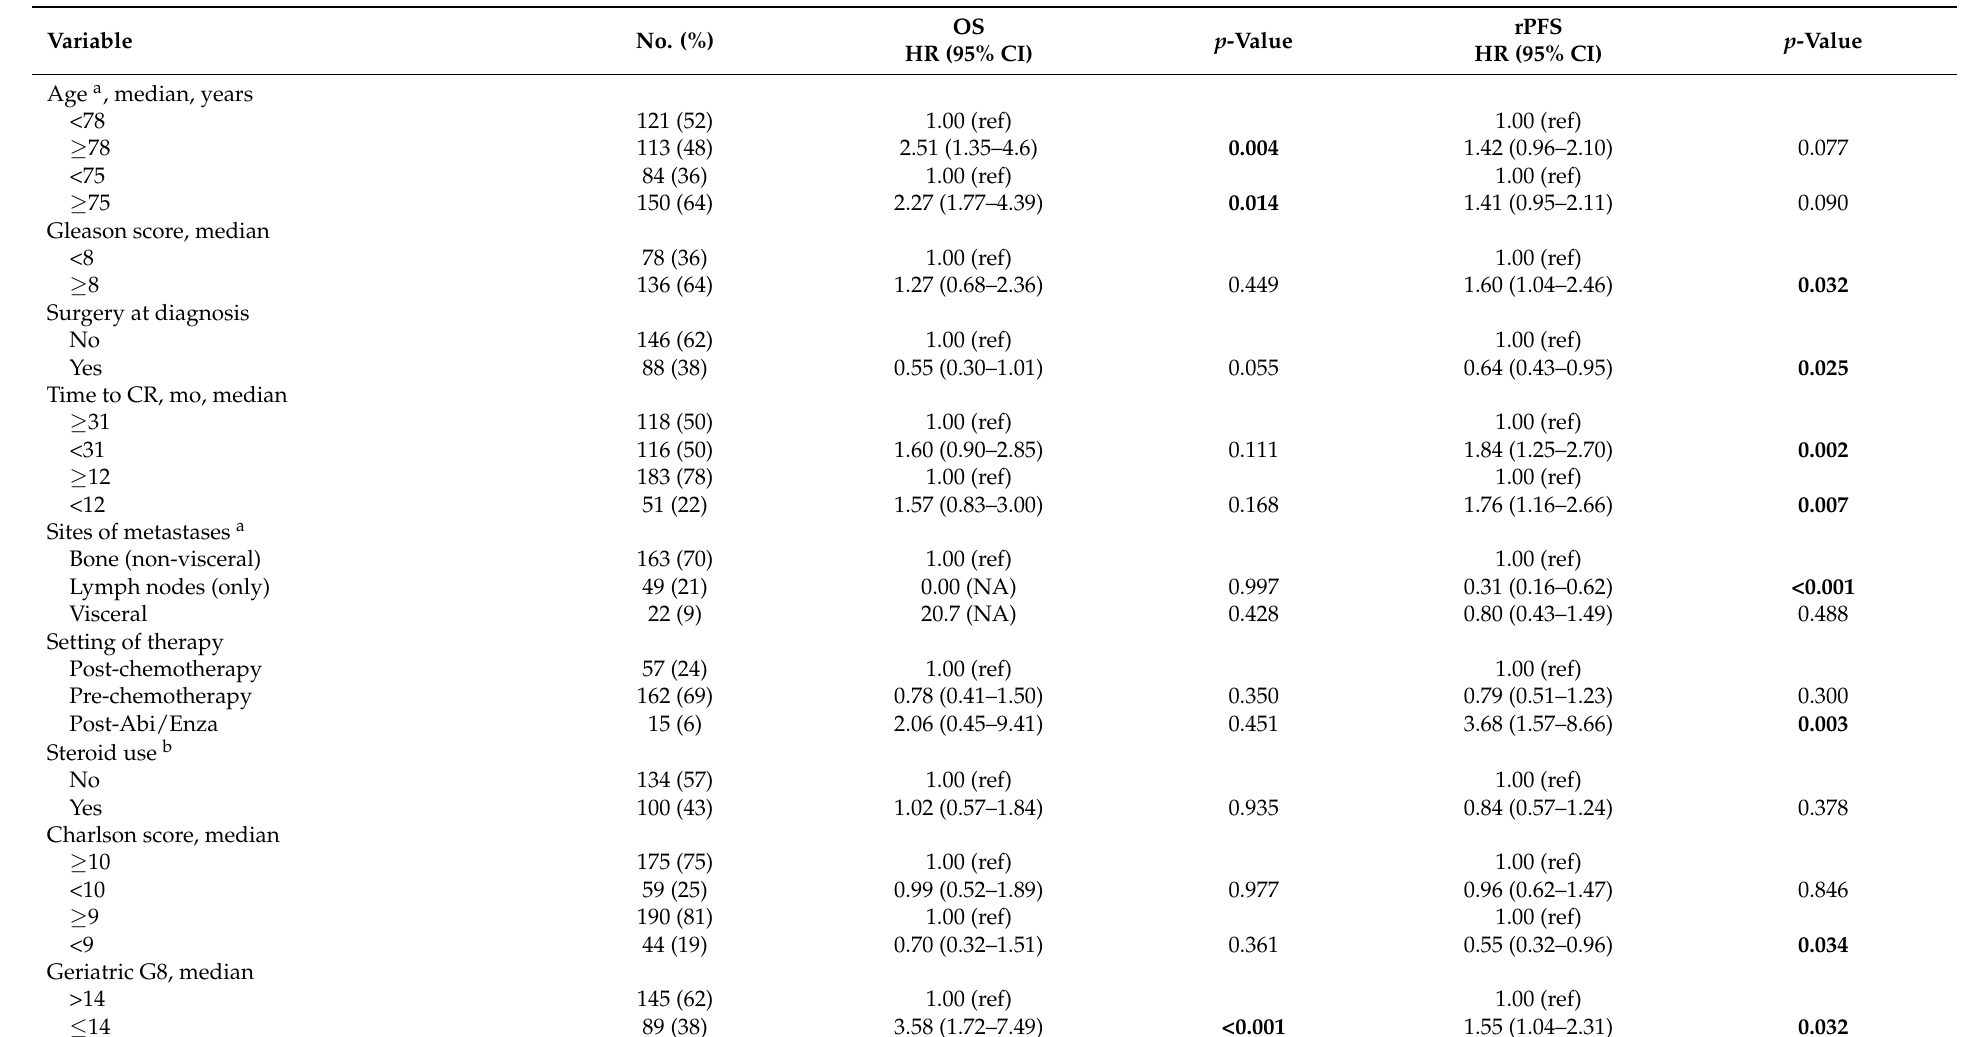
Table 1. Cox regression univariable analysis of clinical baseline and on-treatment